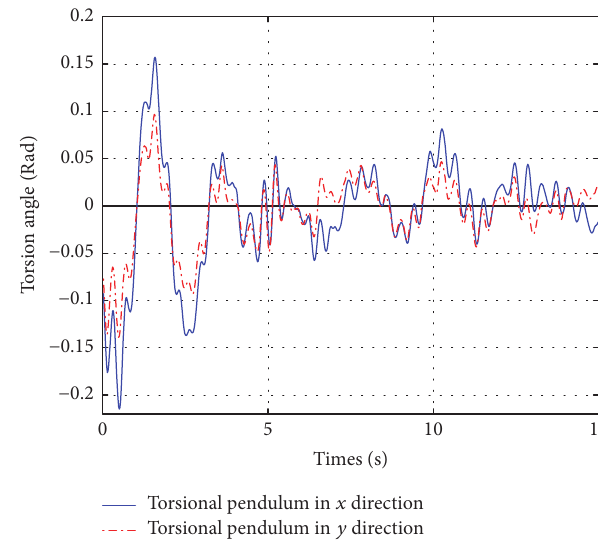
Figure13:Displacementhistoryoftunedmassblocksin 𝑦 direction.